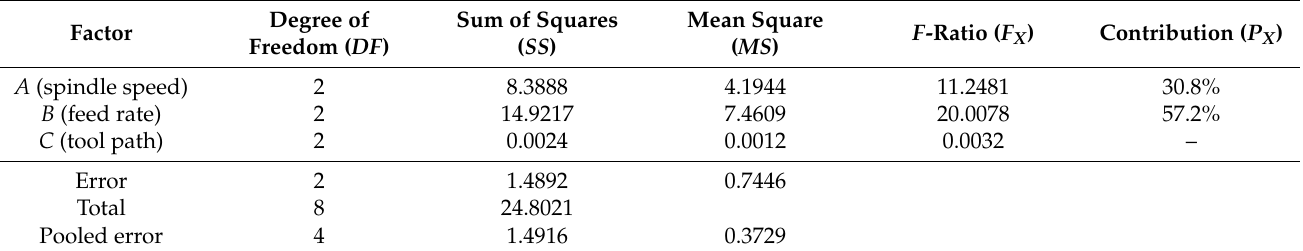
Table 17. ANOVA for surface roughness.